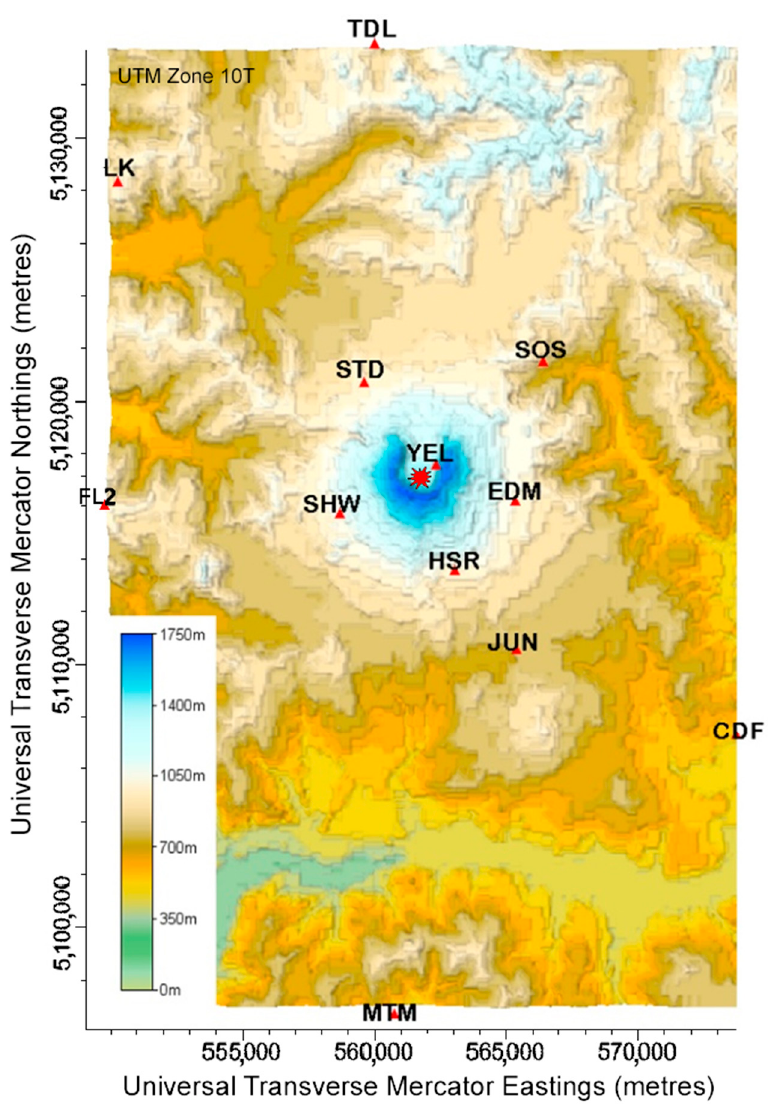
Figure 4. Topographical map of Mount St. Helens volcano. Receiver stations used in the study are marked by red triangles. The LP drumbeat source is identified as a red star approximately 200 m beneath the growing dome.